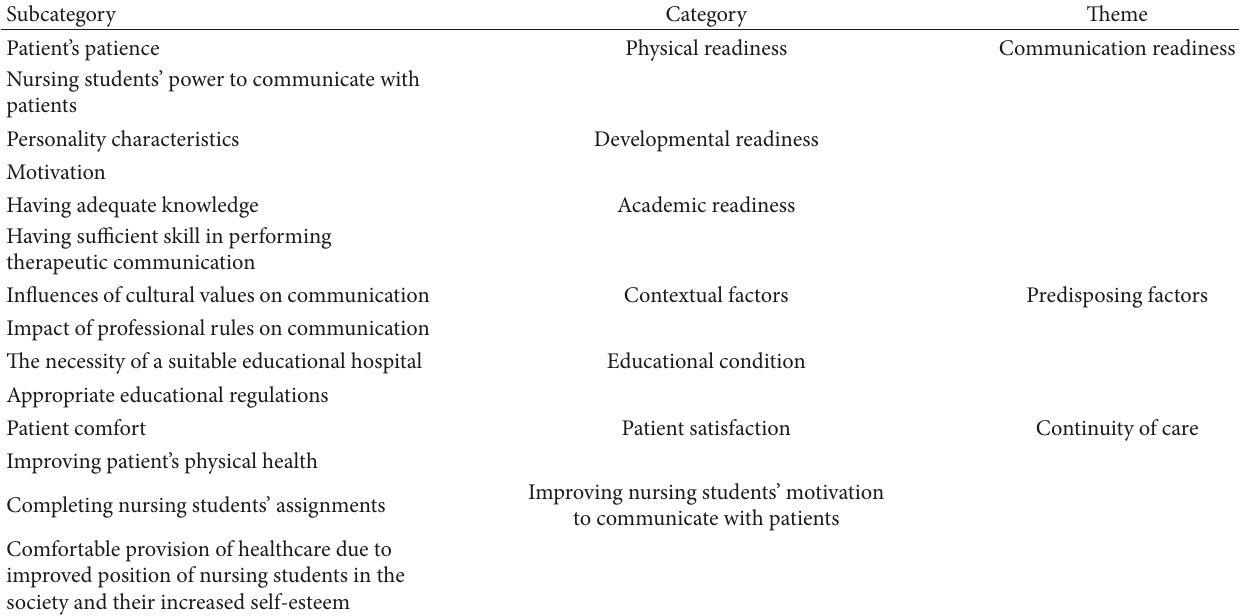
Table 2: The major themes of therapeutic communication and its corresponding